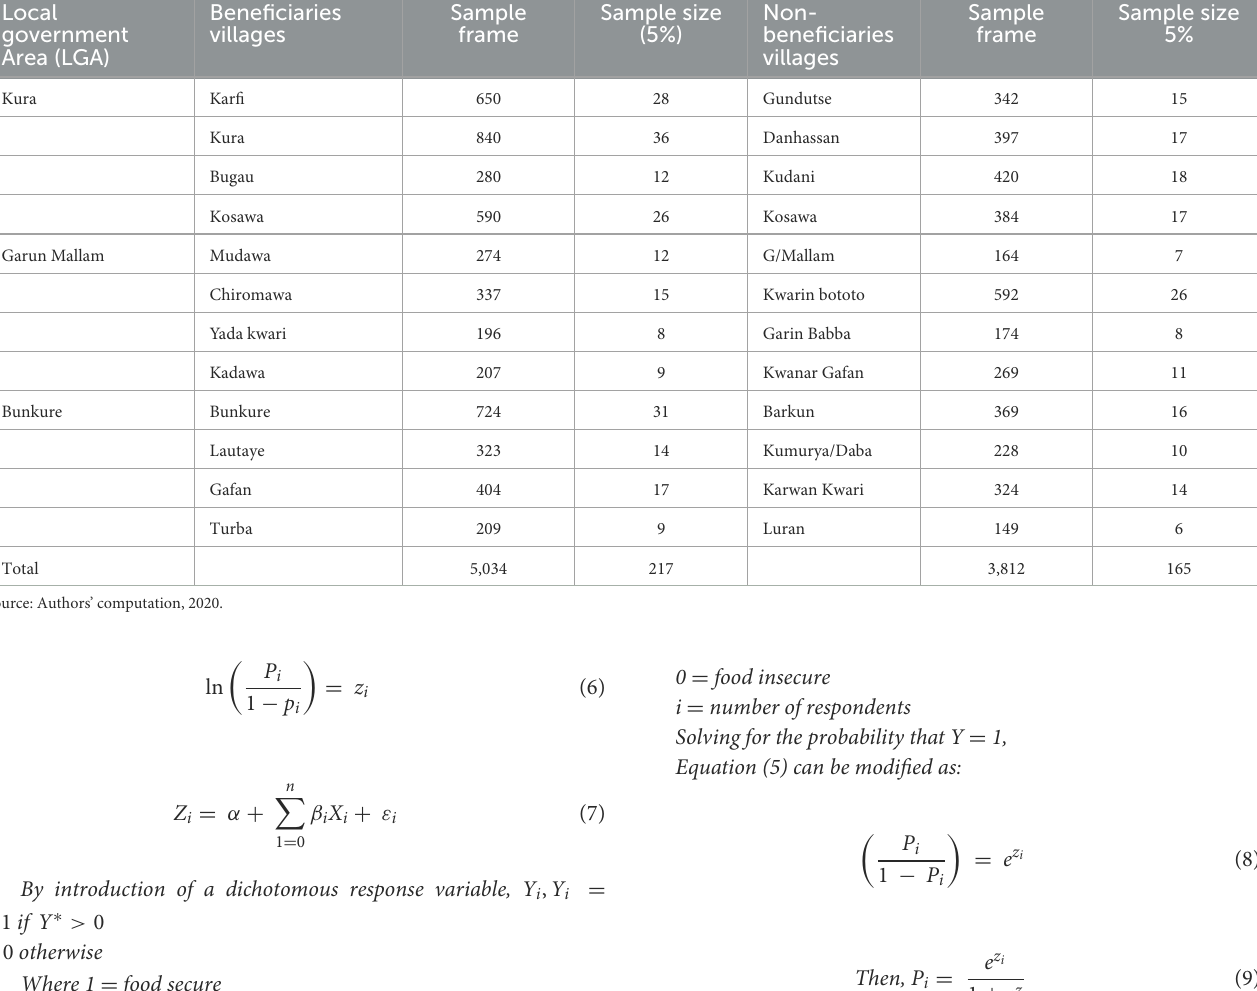
TABLE 1 Sample procedure and sample